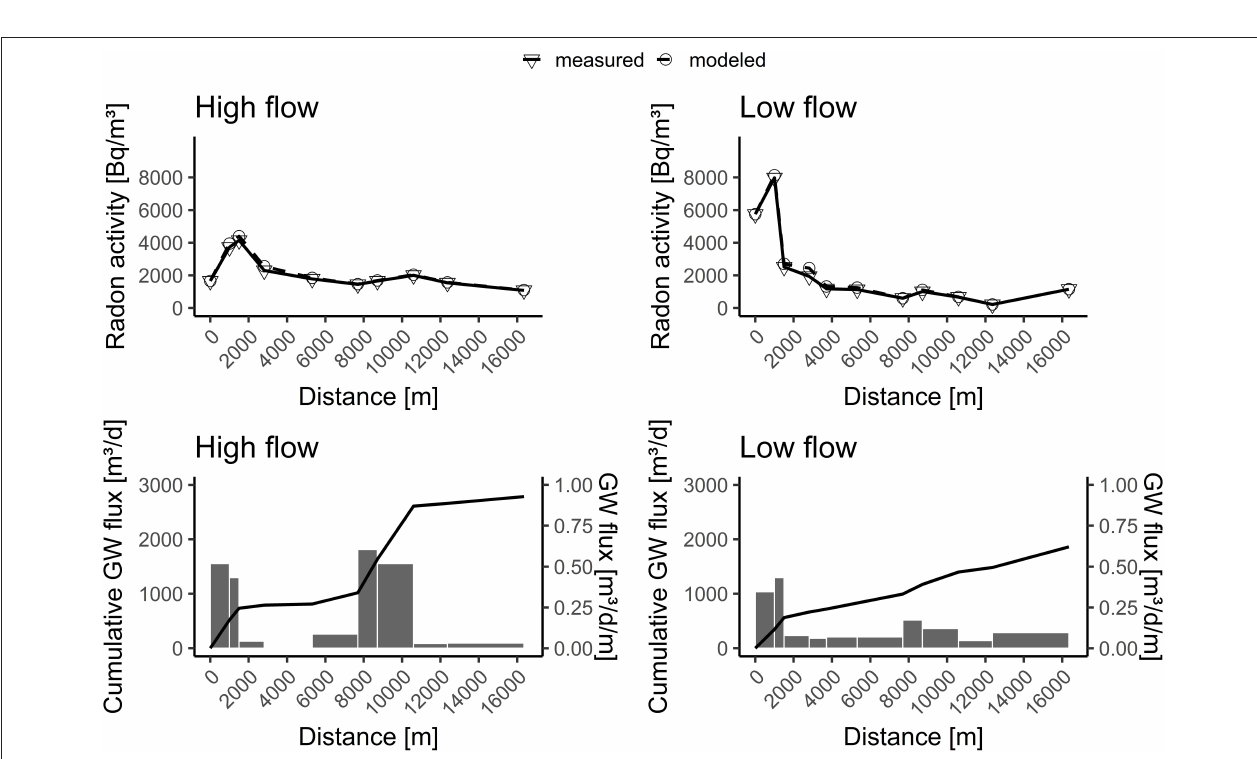
inflow and stream discharge. However, the percentage of groundwater in the stream is negatively correlated to increasing discharge